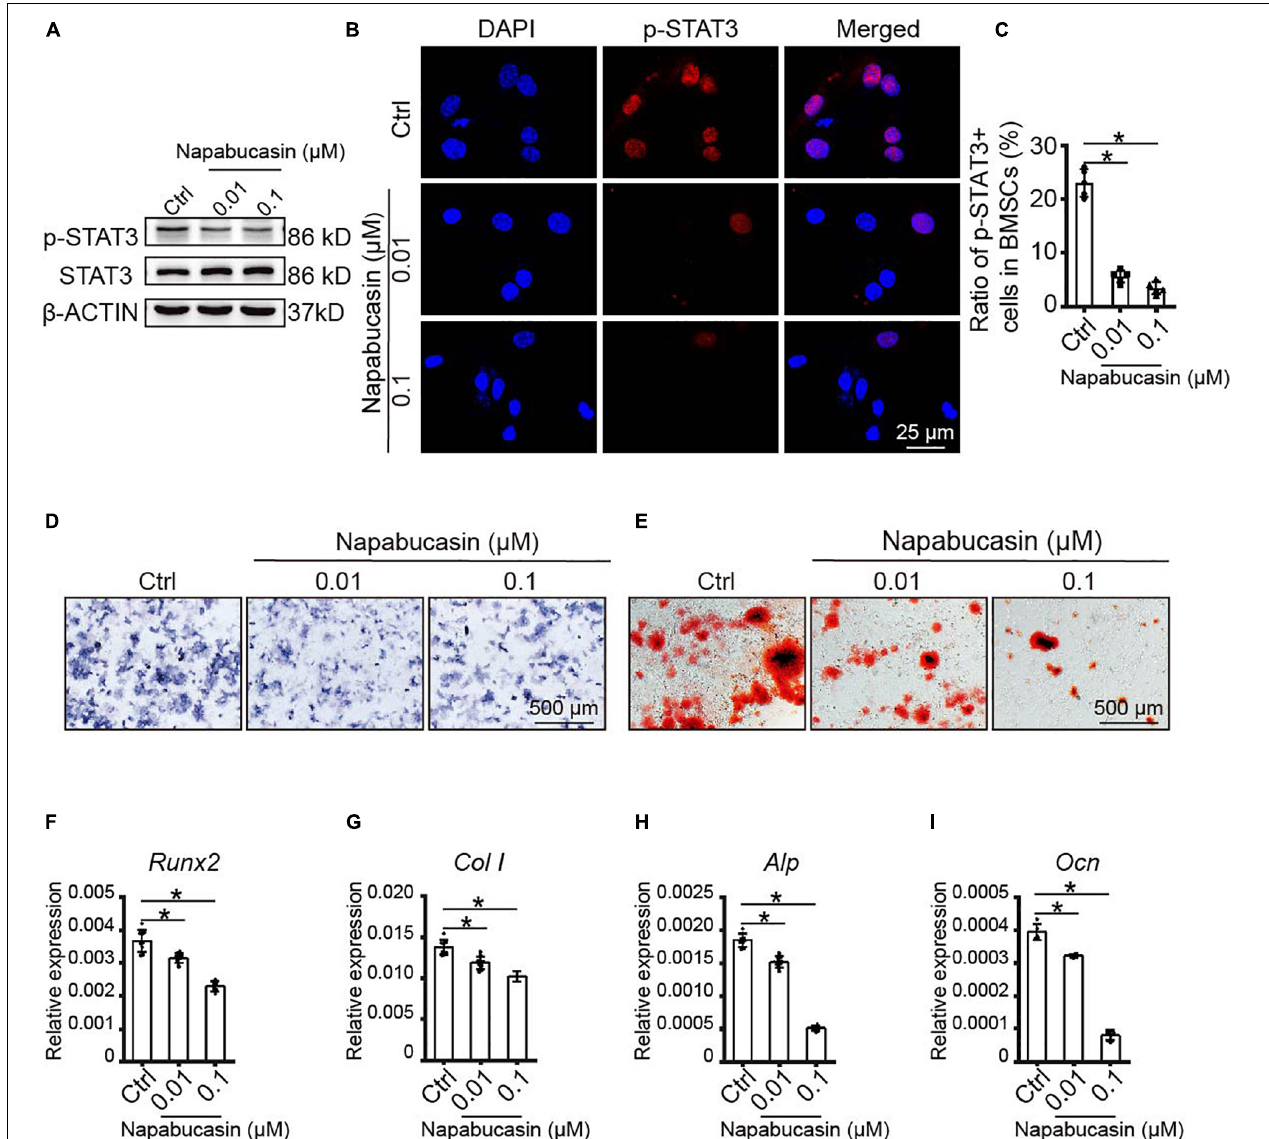
FIGURE 2 | Napabucasin impaired osteoblast differentiation of WT BMSCs. (A) Western blotting assay of STAT3 and pSTAT3 expression in BMSCs treated with DMSO or with different concentrations of Napabucasin for 12 h. (B) Representative immunofluorescence image of pSTAT3 expression in BMSCs after exposure to Napabucasin. (C) Number of pSTAT3 + cells were counted. N = 5. (D) ALP staining of BMSCs after osteoblast differentiation for 7 days following treatment with DMSO or with different concentrations of Napabucasin. (E) Alizarin Red staining of BMSCs after osteoblast differentiation 14 days following treatment with DMSO or with different concentrations of Napabucasin. (F–I) Osteoblast-specific expression of genes Runx2 , Col I , Alp , and Ocn in BMSCs during osteoblast differentiation after treatment with DMSO or with different concentrations of Napabucasin for 7 days. N = 9. Data are represented as means ± S.D. * P <